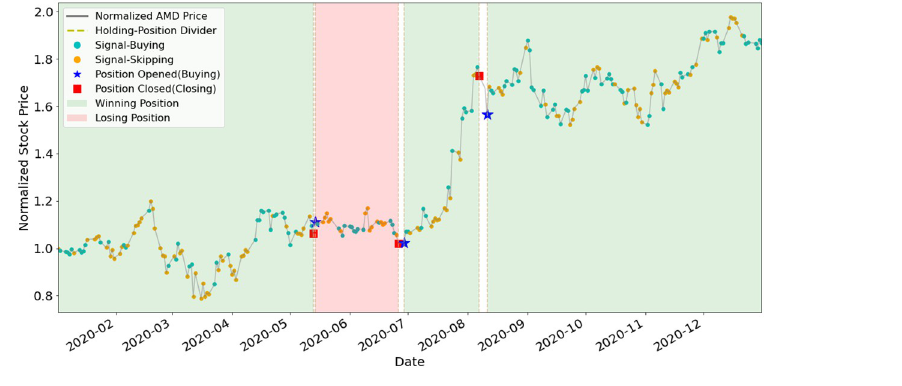
Fig 12. Signals and position-holding of AMD’s EAM.